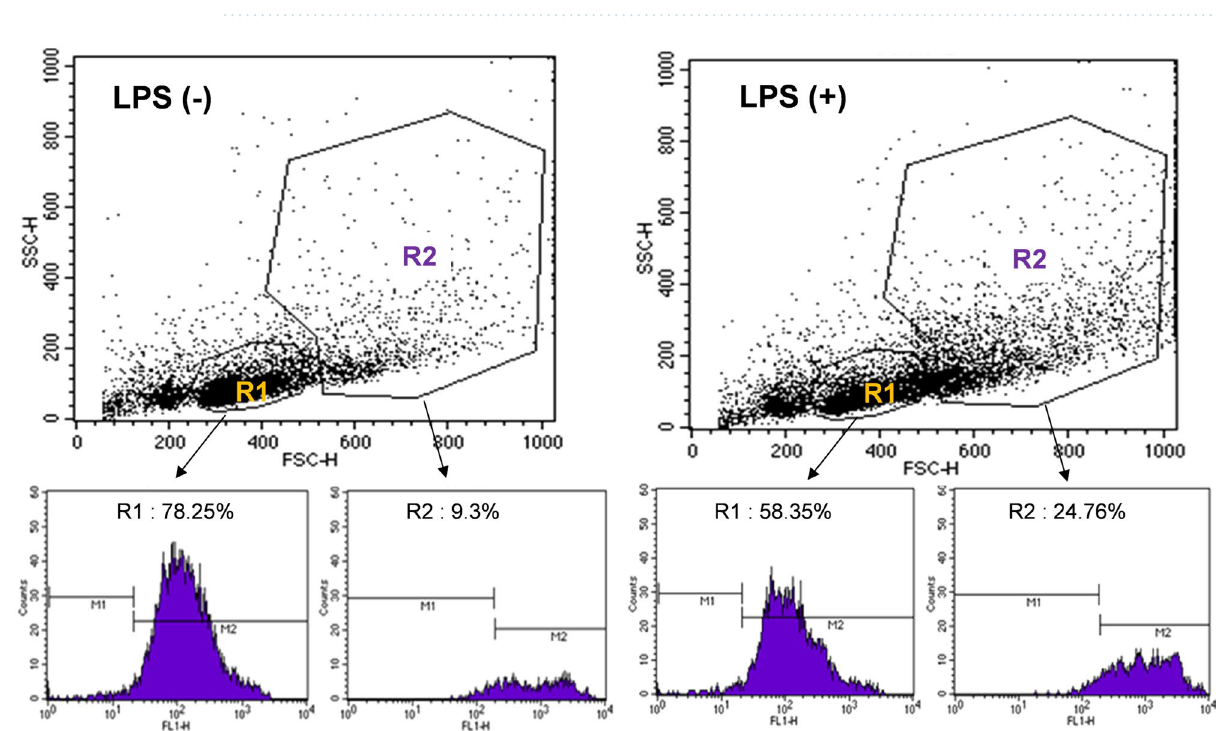
Figure 4. CD44 expression on leukocytes isolated from spleen of mice with or without LPS treatment. Representative forward and side scatter analysis plots show an increase of cells in R2 after mice were treated with LPS (top). Flow cytometry histograms using FITC-anti-CD44 show that LPS stimulates a substantial increase of CD44 expression on cells in R2 but not R1